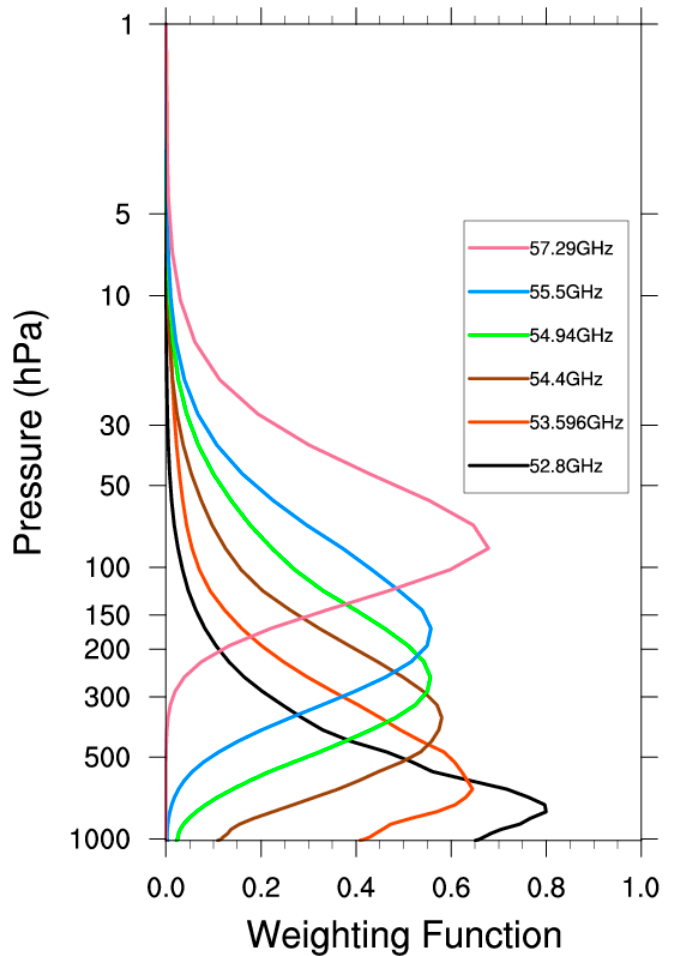
Figure 1. Weighting functions for six channels for remote sensing of the troposphere. Atmospheric profile data from Radiative Transfer for TIROS Operational Vertical Sounder TOVS (RTTOV) were used in the calculations.